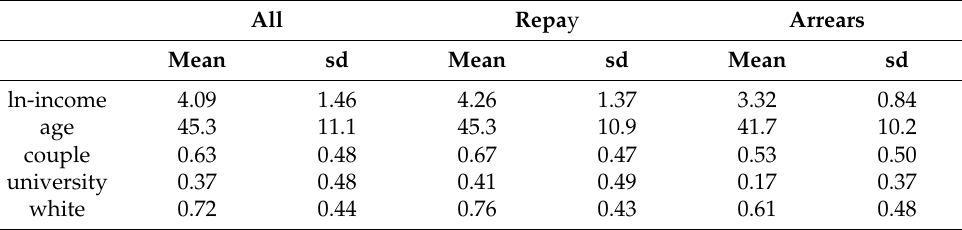
Table 1. Summary Statistics. All Repa